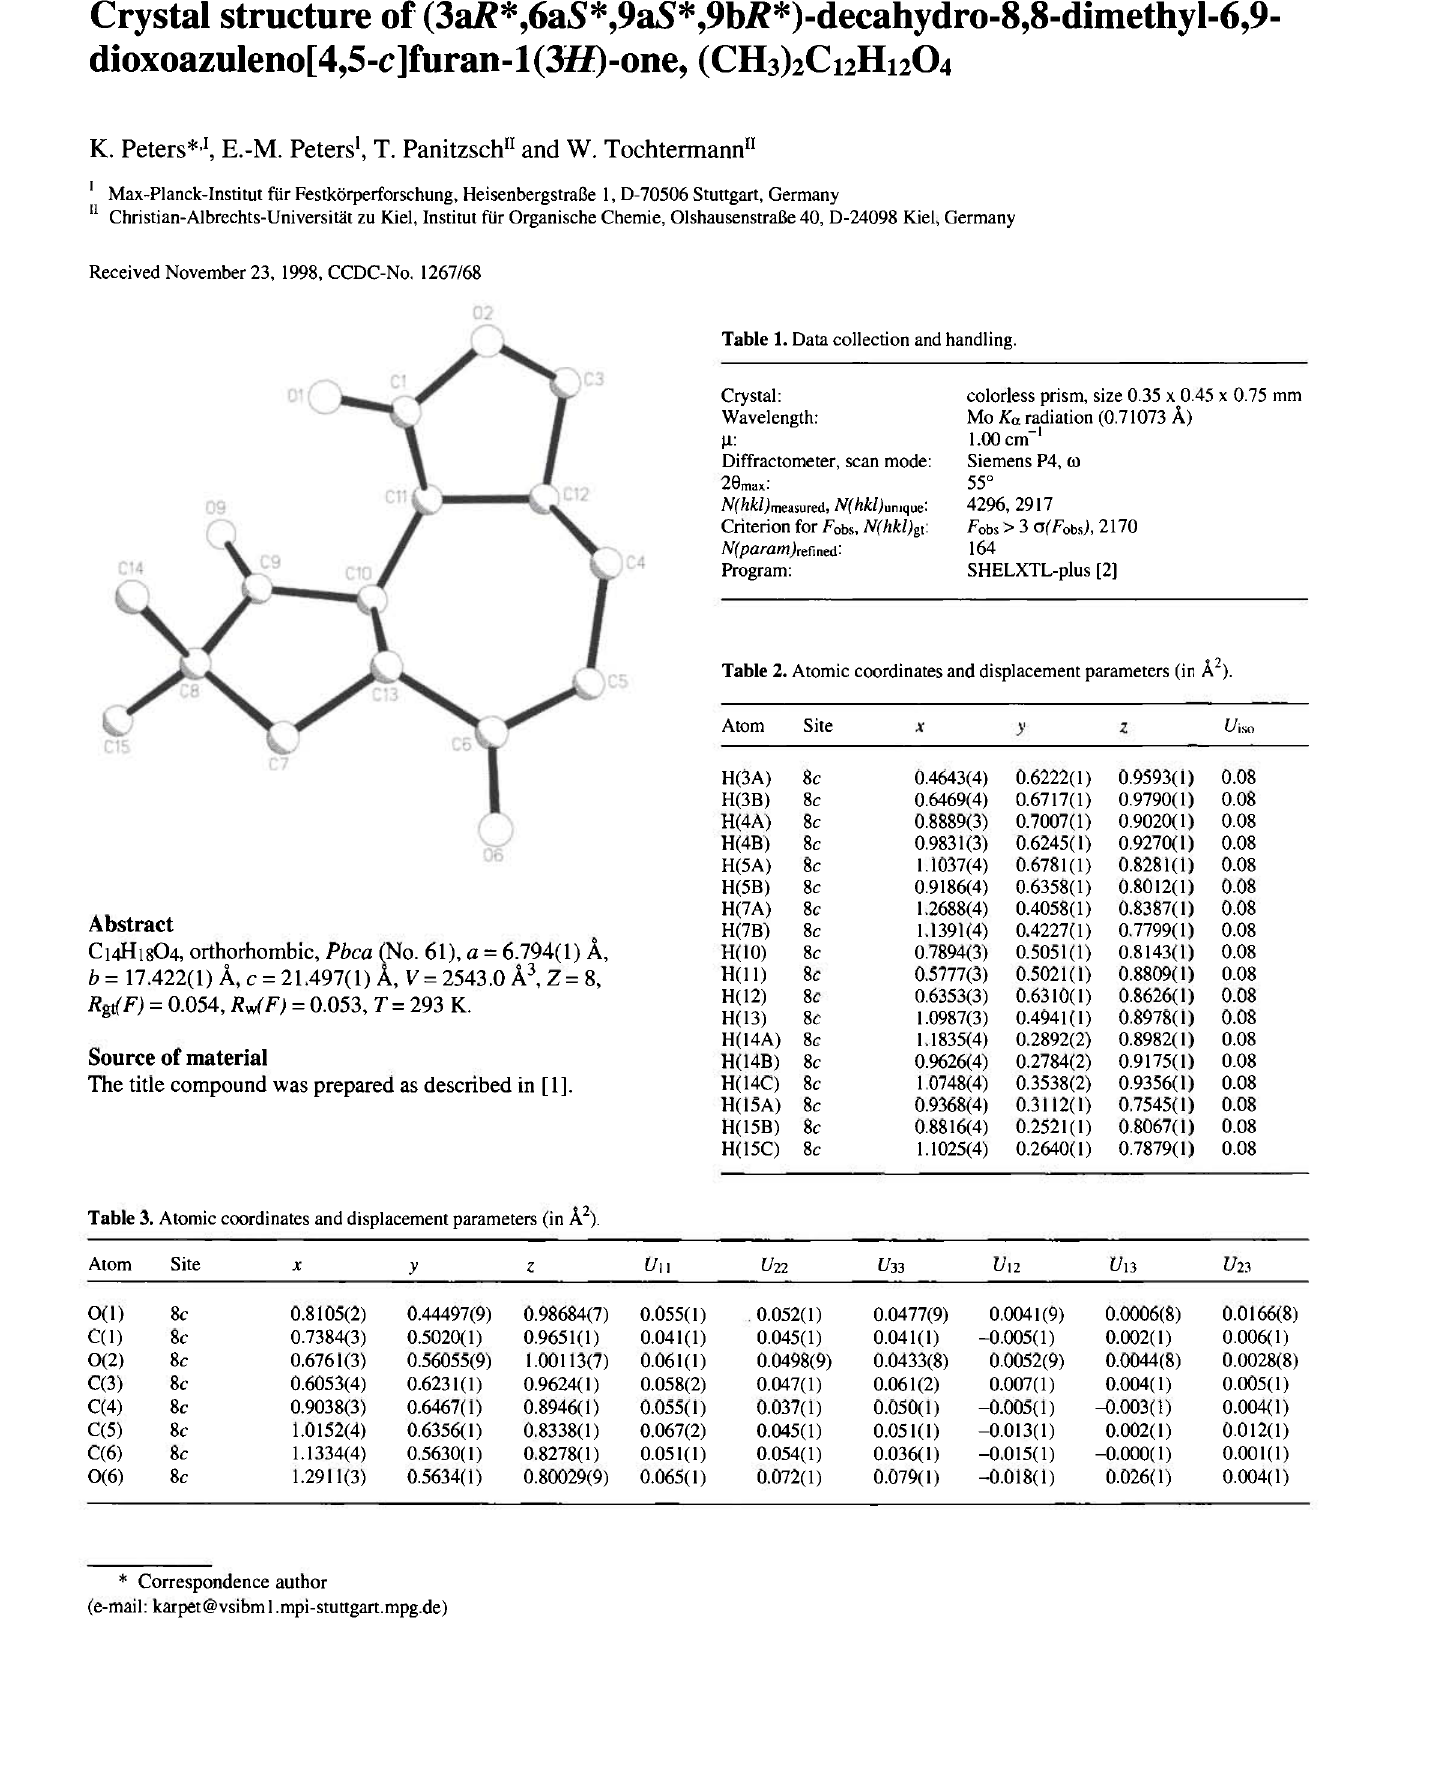
Table 1. Data collection and handling.